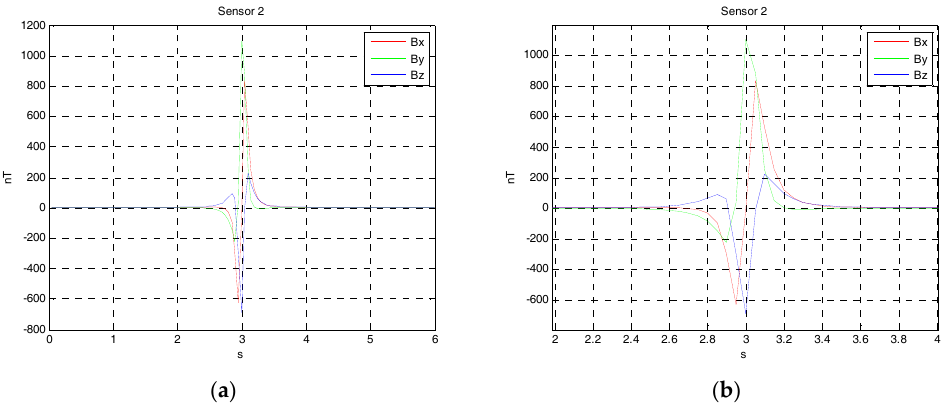
Figure 6. ( a ) The three components alternating magnetic field data acquire by sensor 2 from the time of 0 s to 6 s; ( b ) The three components alternating magnetic field data acquire by sensor 2 from the time of 2 s to 4 s.